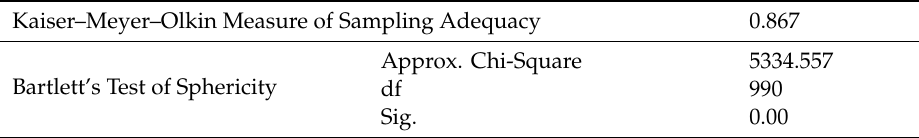
Table 1. Kaiser–Meyer–Olkin (KMO) and Bartlett’s